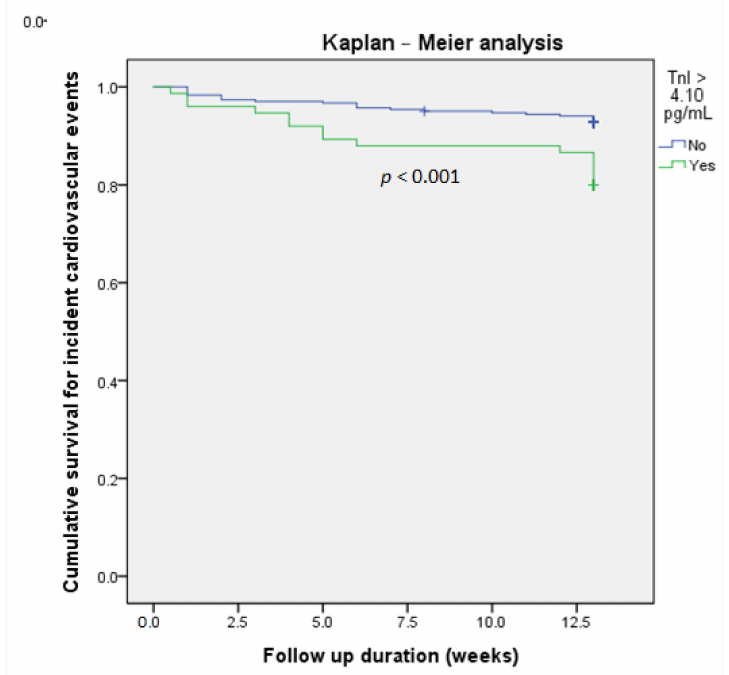
Figure 2. Kaplan-Meier curve analysis of fresh urine hs-TnI concentration > 4.10 pg / mL vs. cumulative survival for incident cardiovascular events in patients with diabetes mellitus (DM).